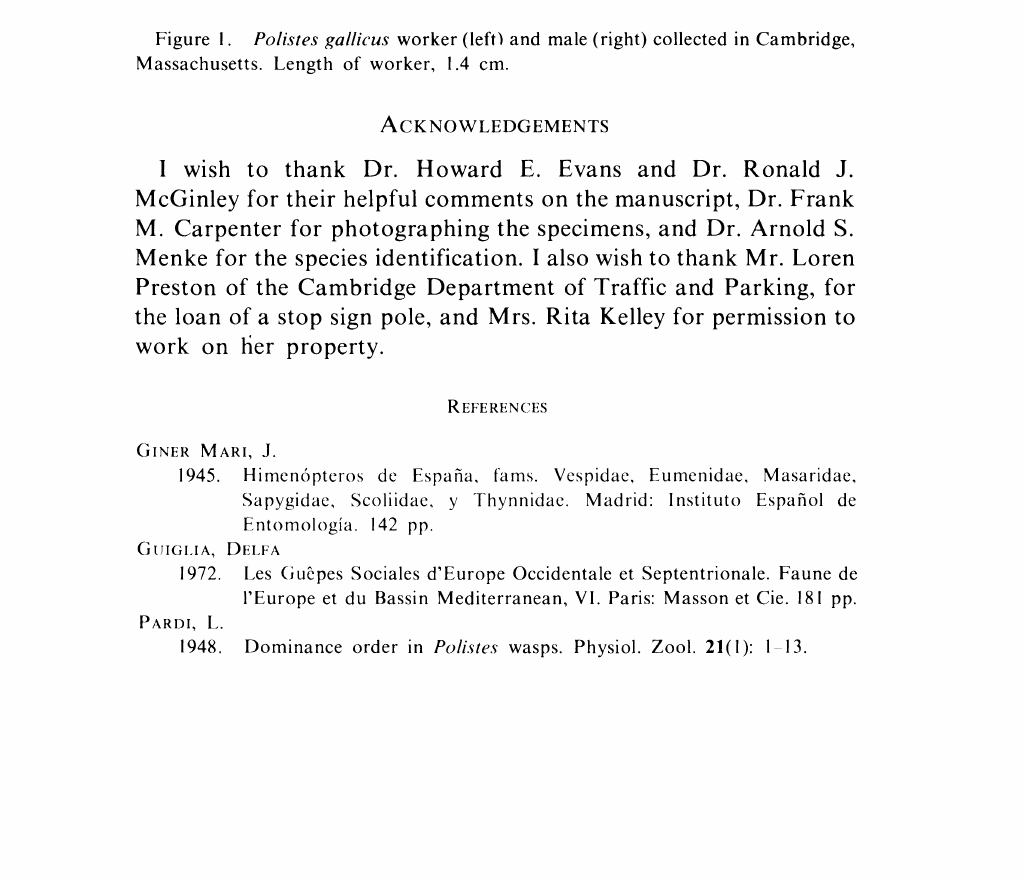
Figure I. Polistes gallicus worker (left and male (right) collected in Cambridge, Massachusetts. Length of worker, 1.4